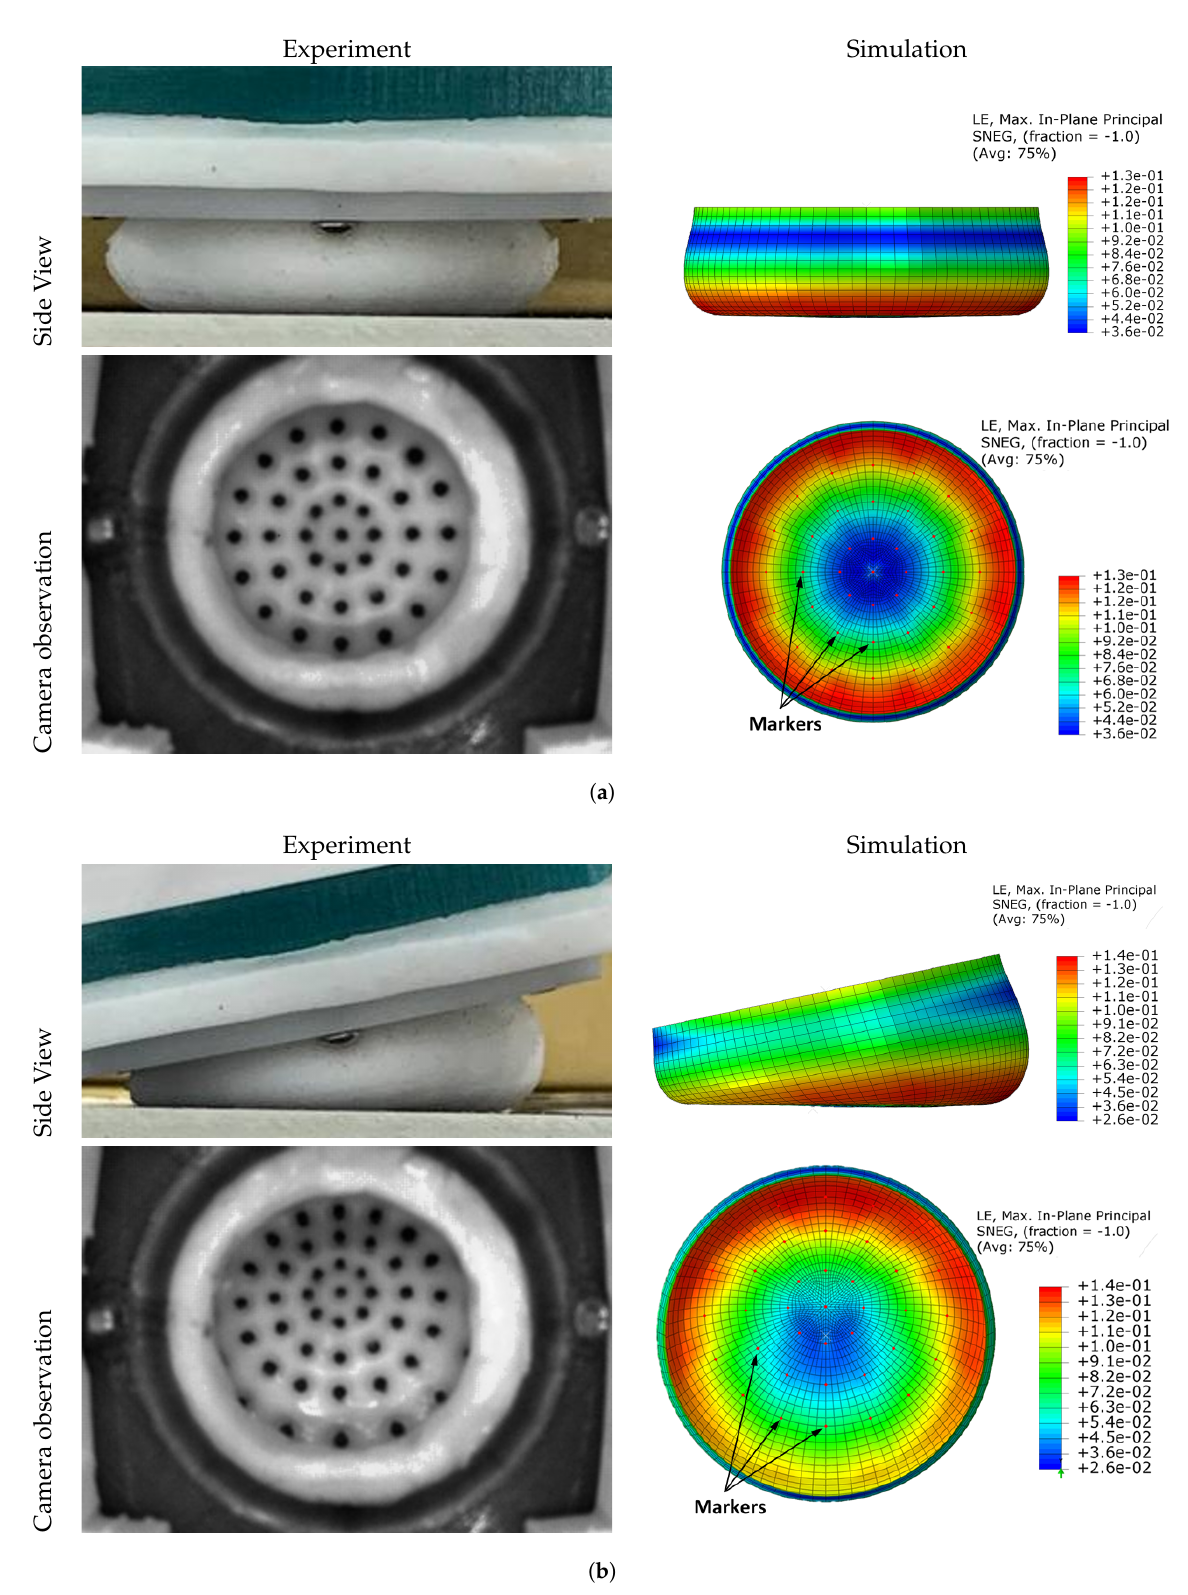
Figure 10. Actual and simulated results of the sensor deformation at different angles. ( a ) at angle 0 ◦ . ( b ) At angle 12 ◦